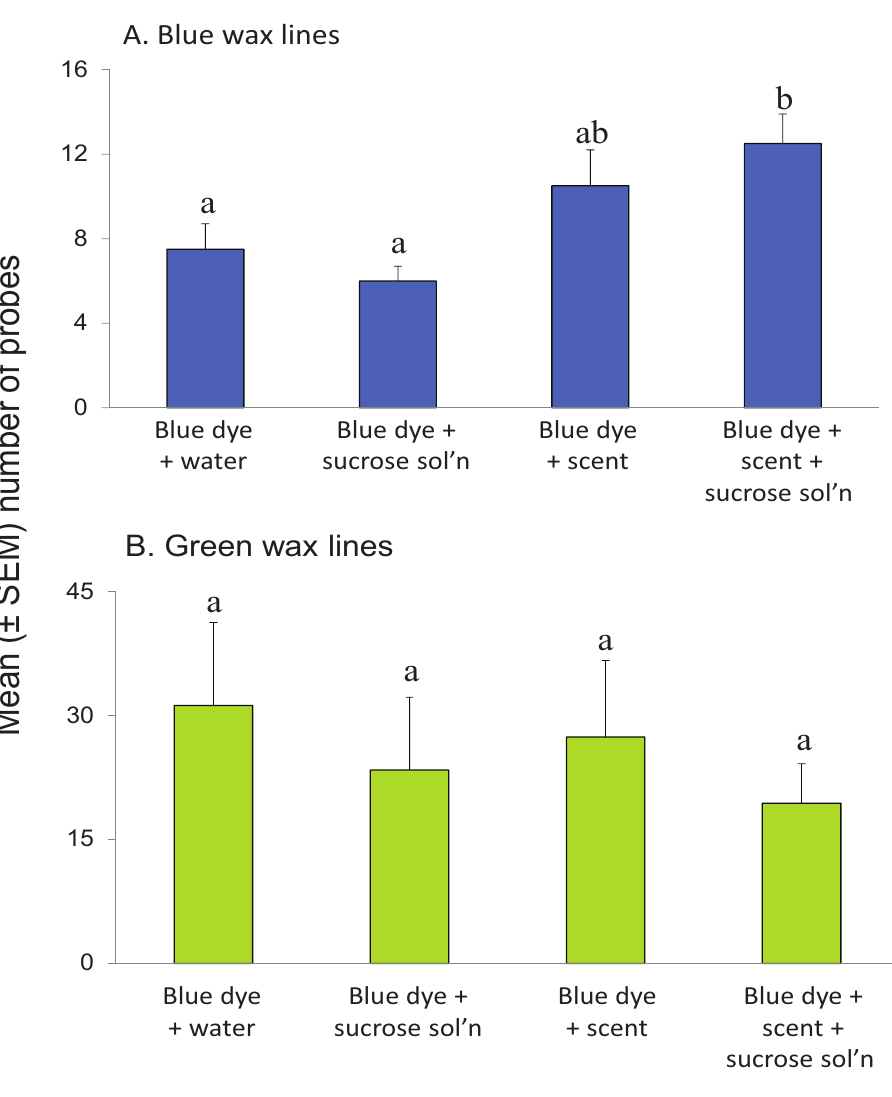
Figure 6. Probing responses of psyllids to blue (A) or green (B) SPLAT lines following experience on various combinations of visual, nutritive, and olfactory stimuli. Letters within the same row are different at p (cid:5) 0.05 (Planned comparisons with t-tests). Note differences in y-axis values between upper and lower graphs. N = 10 for each treatment.